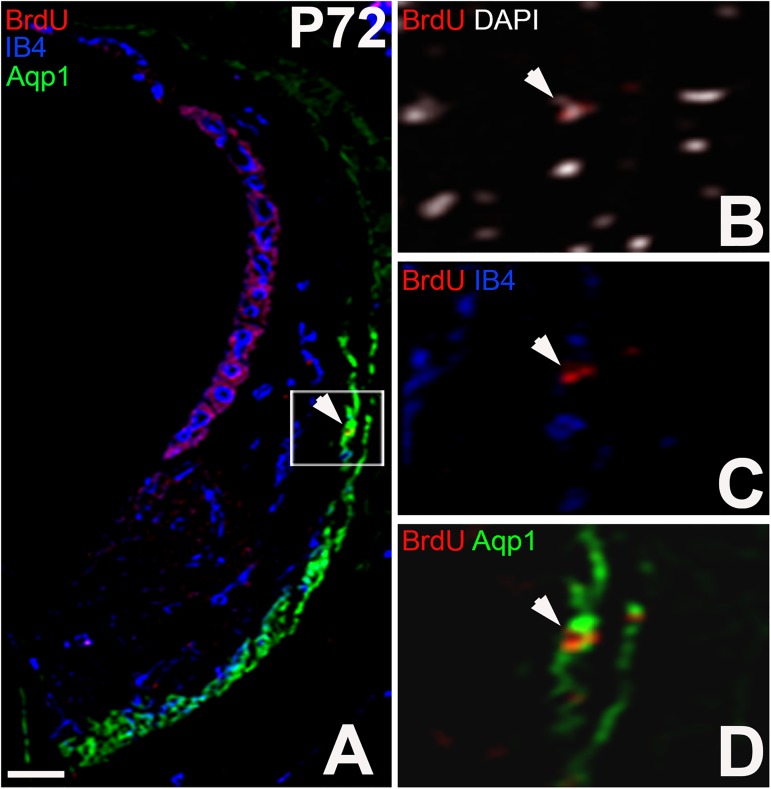
Retained expression of BrdU+IB4- cells in type 3 area at P72.(A) Triple immunostaining for BrdU, IB4 and Aqp1. (B, C, D) Enlarged image of corresponding boxed area in (A). Arrows indicate BrdU positive Aqp1 expressing fibrocytes. Note that BrdU was injected in between P6 and P12, indicating that those BrdU positive Aqp1 expressing type 3 fibrocytes were long-term BrdU retaining cells. Nuclei were stained using DAPI (B). Scar bar = 100μm.